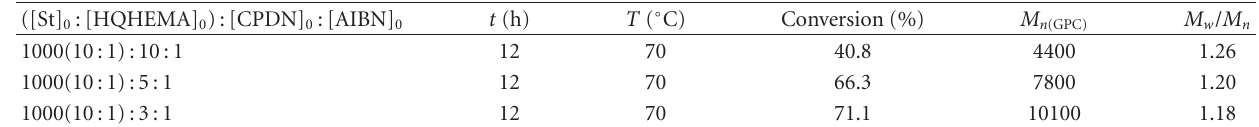
Table 2: RAFT copolymerization of St and HQHEMA with di ff erent CPDN concentrations.